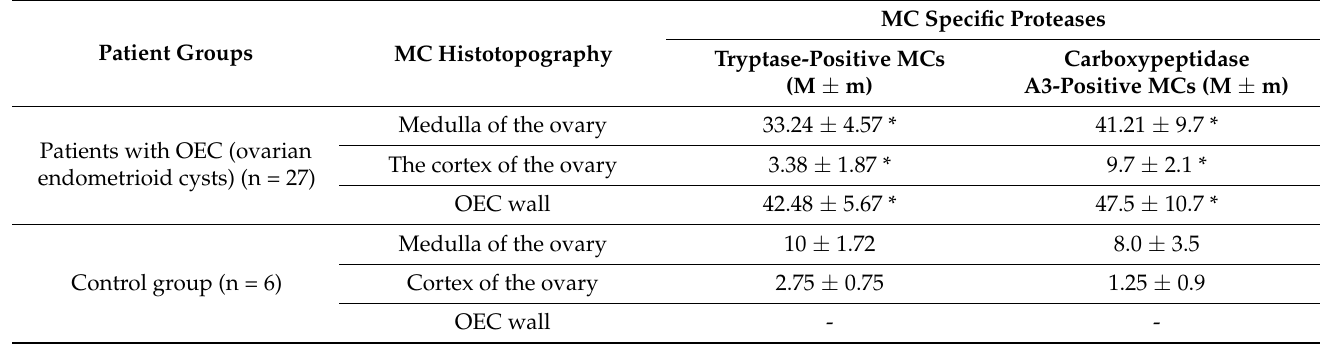
Table 1. Number of mast cells in the ovary (per mm 2